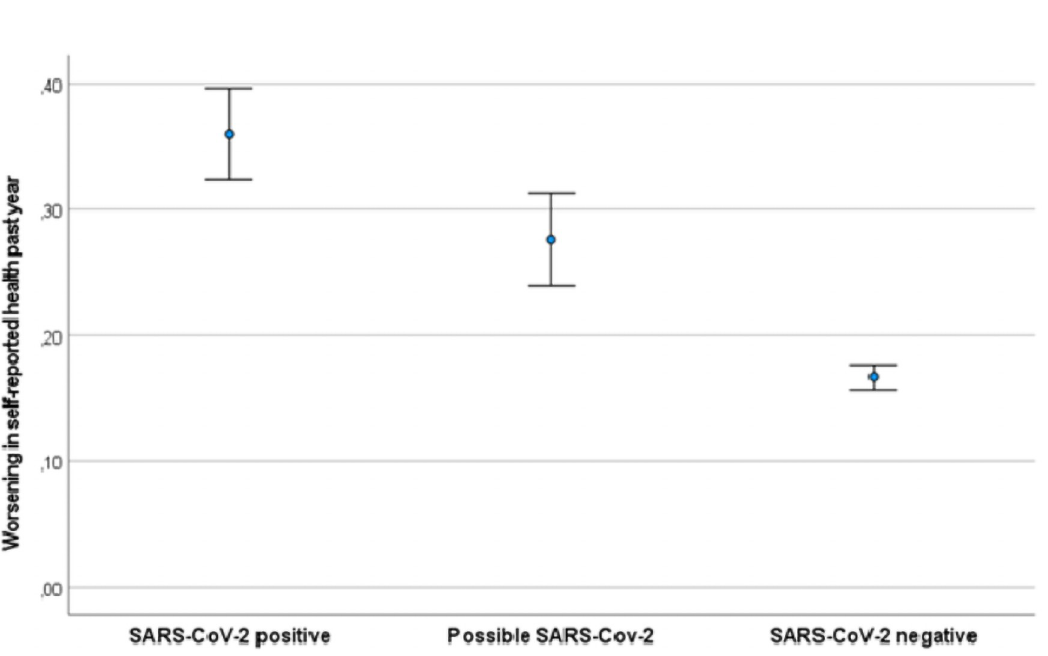
Fig 3. Proportion of participants reporting a worsening of health past year at 3–8 months after baseline stratified on likelihood of previous COVID-19. The figure shows the proportion of participants reporting a “somewhat” or “much” worse health than one year ago at the time of follow-up. Questionnaire data on symptoms at baseline was used to classify patients. “SARS-CoV-2 positive” status was based on RT-PCR at Norwegian accredited laboratories. “Possible SARS-CoV-2” was patients with a negative PCR test, but reporting changes to the senses of smell or taste at baseline. “SARS-CoV-2 negative” was PCR negative patients not reporting changes to the senses of smell or taste at baseline. Error bars are 95% confidence intervals for the means.